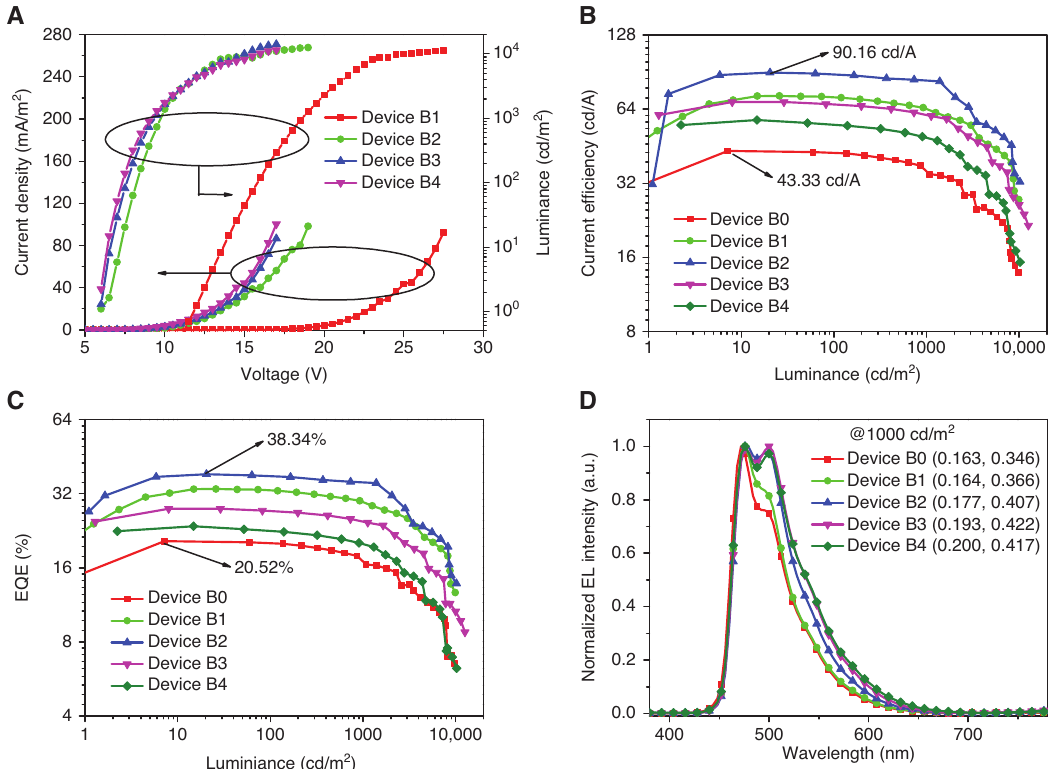
Figure 2: (A) The J-V-L curves of tandem blue devices B1–B4; (B) The CE–L (B) and EQE–L (C) curves of all single unit and tandem blue devices B0–B4; (D) The EL spectra and CIE coordinates of all single unit and tandem blue devices B0–B4 at 1000 cd/m 2 . The single unit reference device B0 is ITO(180 nm)/HAT-CN(5 nm)/TAPC(40 nm)/TCTA:TmPyPB (1:1): 15 wt%FIrpic(20 nm)/TmPyPB(15 nm)/TmPyPB: